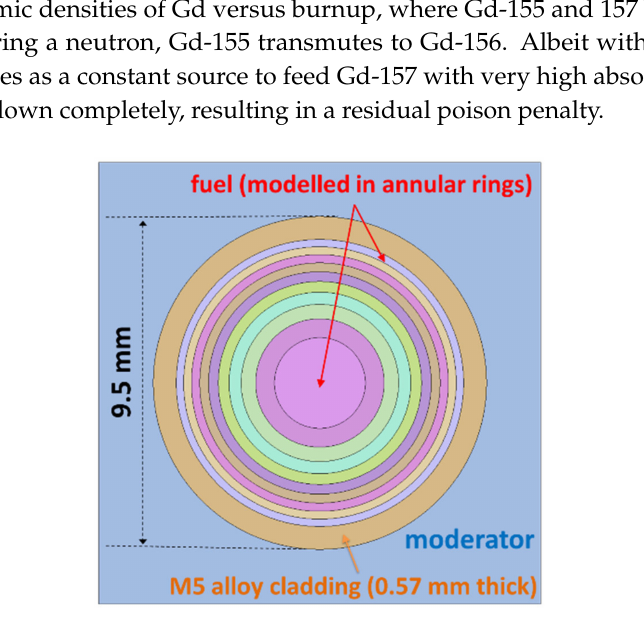
Figure 5. Modelling an EPR fuel unit cell (with Gd) in 10 annular rings of an equal area using Serpent (radial view).